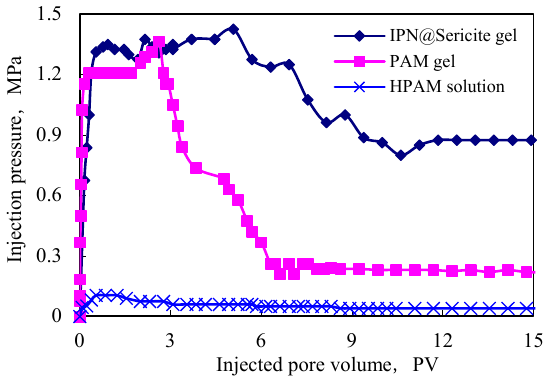
Figure 9. Comparison of blocking performances.